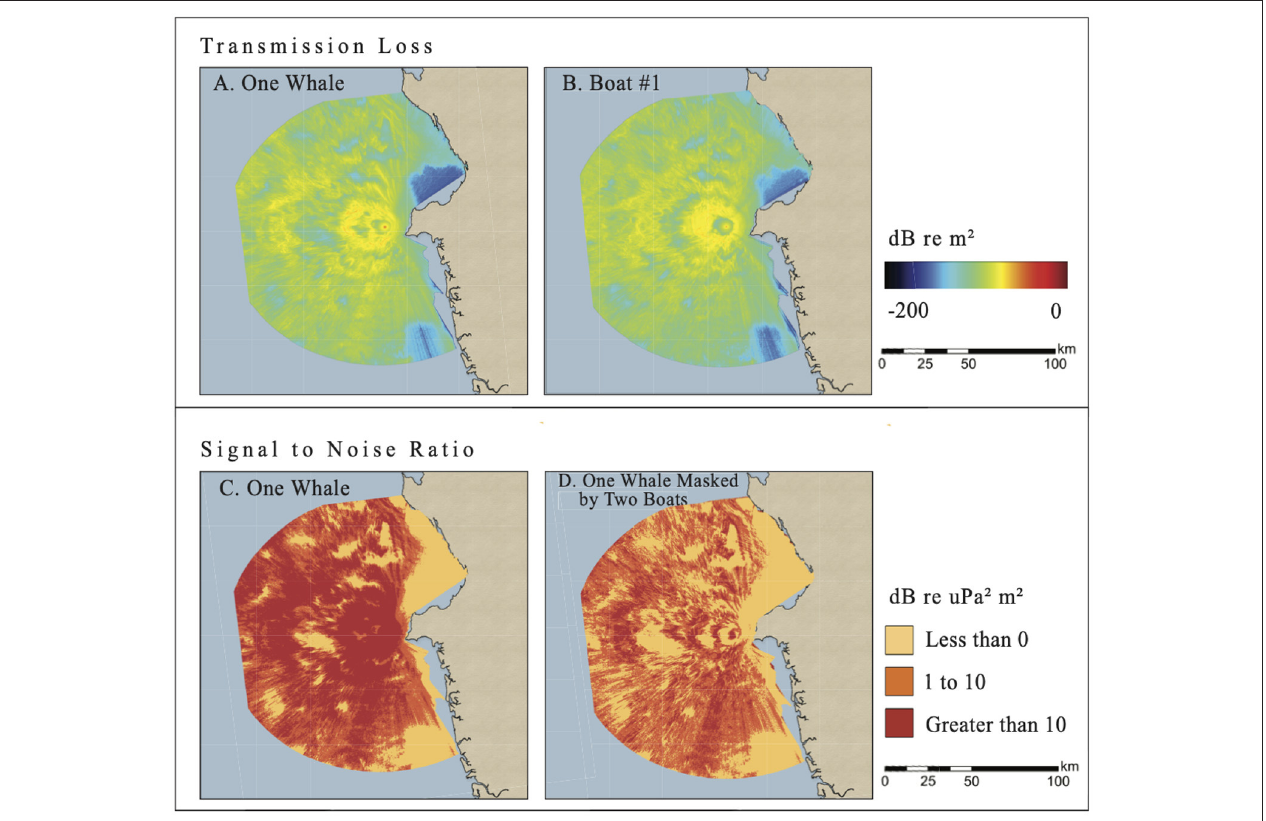
FIGURE 4 | Planview maps for the Sept 20, 2019, scenario #2 of continuous TL values of whale song (top left) and noise from one of the two boats (top right) near Arusá. Blue is less audible while red is more audible. In the bottom panels, planview maps of binned SNR values better visualize the area of relatively higher SNR communication space when only ambient noise (bottom left) vs. two boats (bottom right) are present. Red indicates very audible areas of the whale song, orange indicates unreliably audible areas, and yellow indicates masked areas(color online).